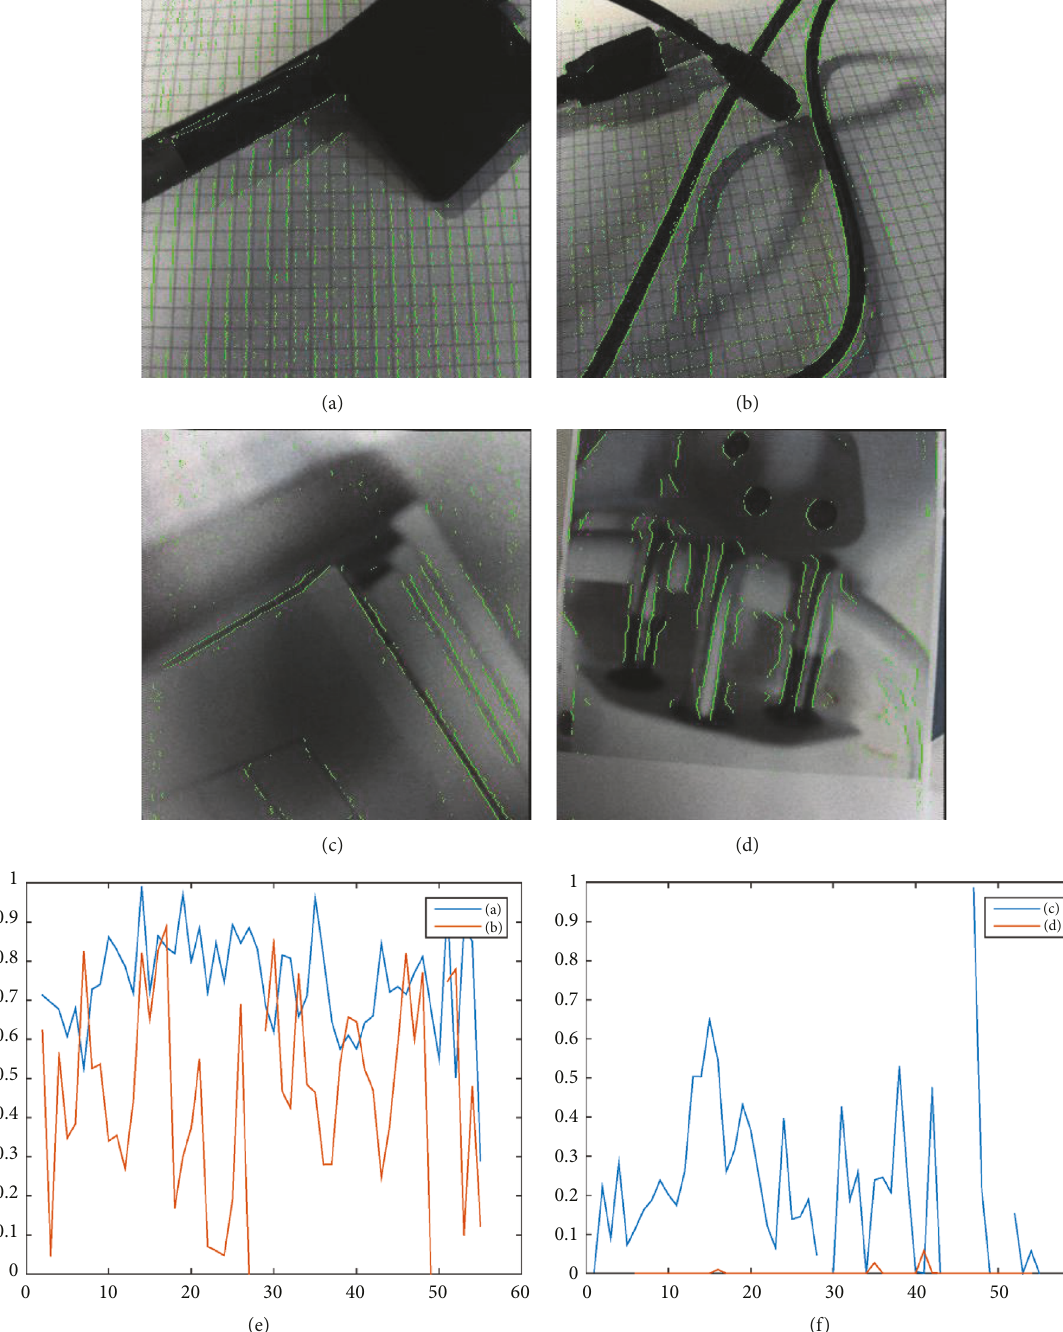
Figure 8: (a)–(d) are four failed samples of our algorithm, where (a) and (b) are misclassified as flat surface, and (c) and (d) are misclassified as natural scenes. The green points are the Lisad-1 points. (e) and (f) are the corresponding distributions of energy